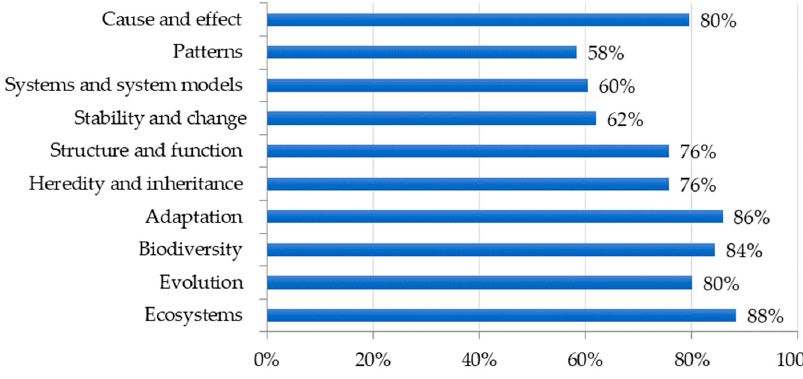
Figure 3. Entomology topics supported by insect incorporation.